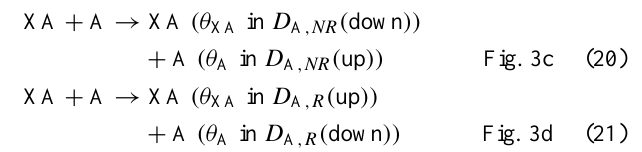
Figure 5 : F. Robert & C. Camy-Peyret in Ozone isotopic composition